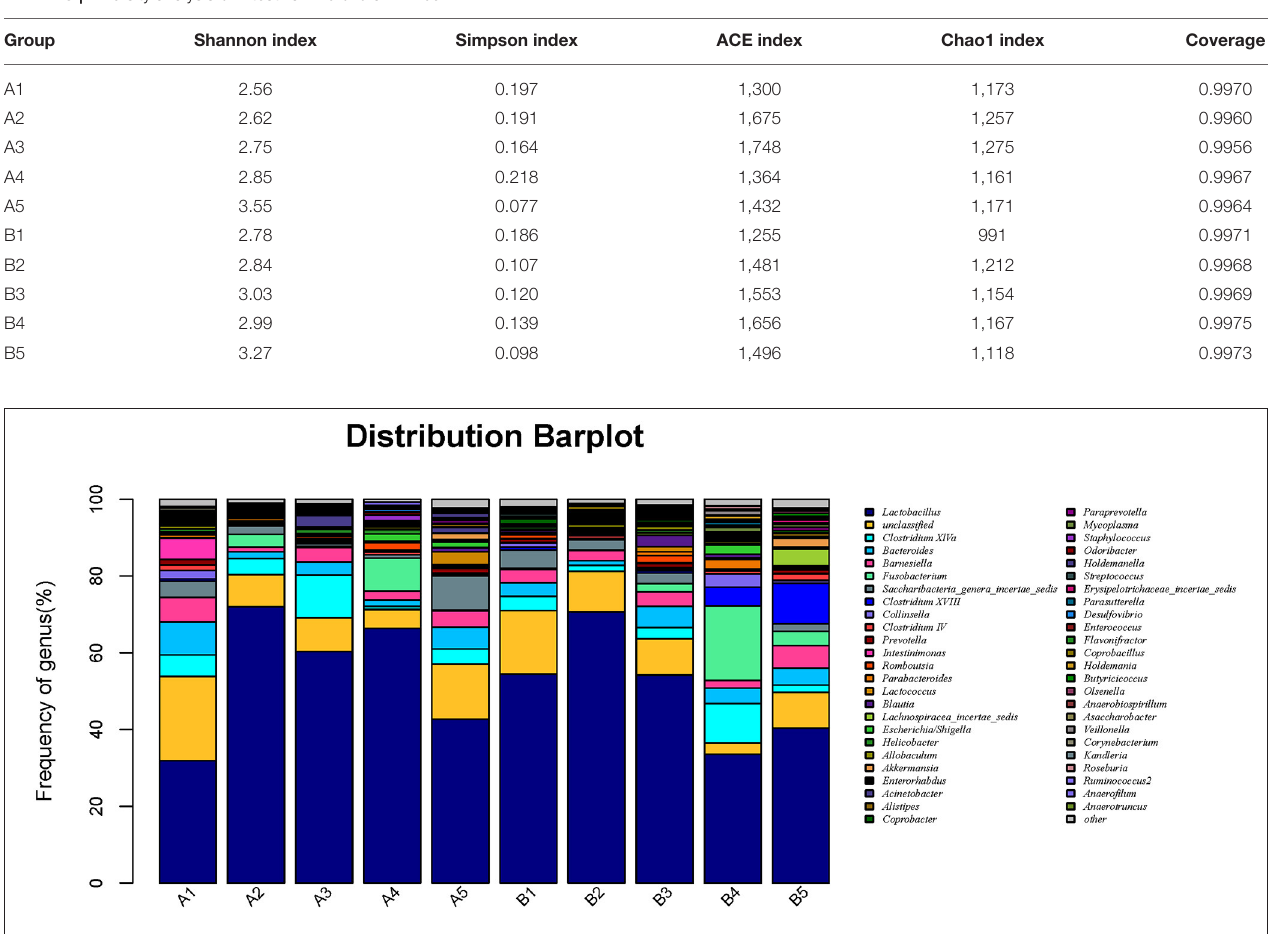
FIGURE 5 | Horizontal abundance of intestinal microflora communities in mice at the genus level. The dominant genera were list from top to low. The horizontal axis is the number of each sample, and the vertical axis is the relative abundance ratio. Colors correspond to species names at this taxonomic level. The different colors and block width represents the relative abundance ratio of different